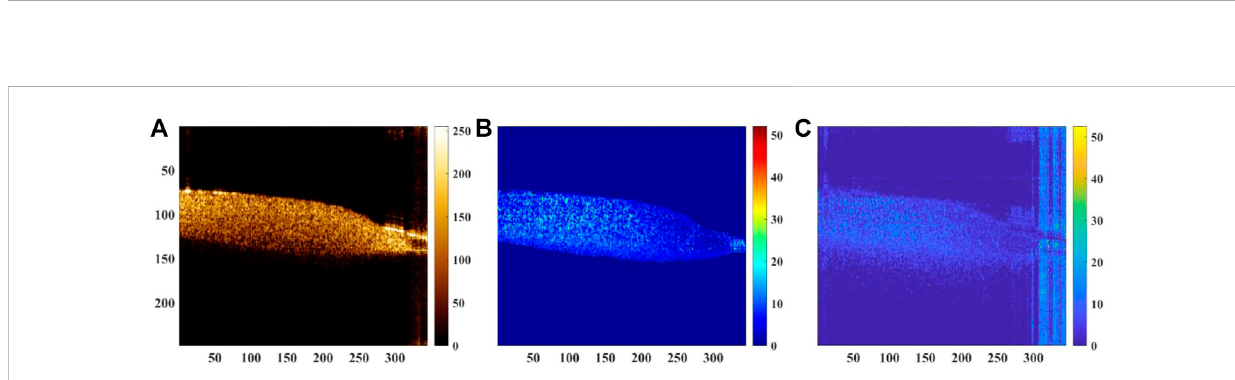
FIGURE 6 (A) Cross-sectional OCT image of whole blood, (B) corresponding speckle variance with CNN segmentation, and (C) corresponding speckle variance without CNN